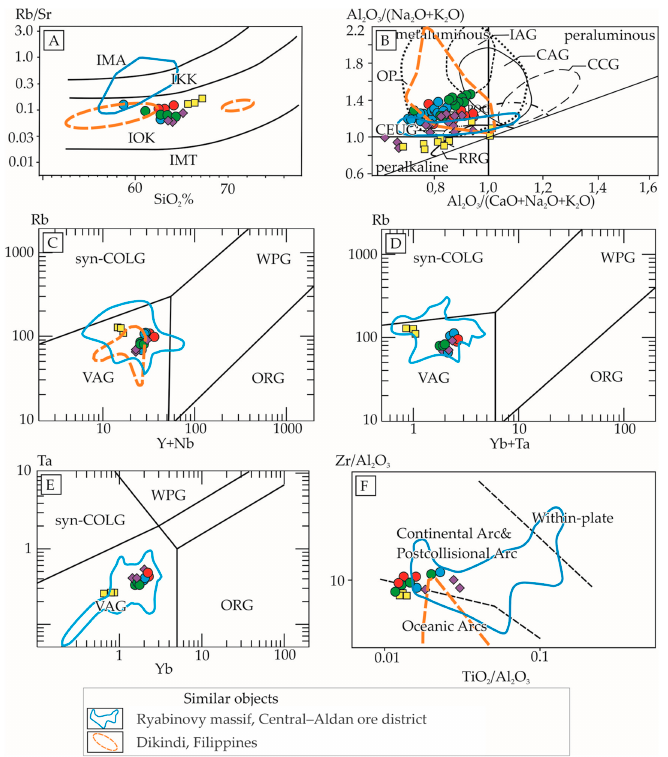
Figure 6. Discrimination diagrams for igneous rocks of the Medvedev, Taezhniy massifs and similar objects [10,24]. Blue line color is Ryabinovy massif, Central–Aldan ore district [14], Red line color is Dikindi, Filippines [1]. ( A ) Rb/Sr-SiO 2 diagram fields [43], igneous rocks: IMT—tholeiitic rock series, IKK—continental crust, IOK—oceanic crust, IMA—alkaline mantle; ( B ) Al 2 O 3 /(Na 2 O + K 2 O) − Al 2 O 3 /(CaO + Na 2 O + K 2 O) diagram fields [46]: IAG—island arc granitoids, CAG—granitoids of continental arcs, CCG—granitoids of continental collision settings, POG—postorogenic granitoids, RRG—rift-related granitoids, CEUG—granitoids of continental epiorogenic uplifts, OP—oceanic plagiogranites; ( C – E ) Rb − Y + Nb, Rb − Tb + Ta, Ta − Yb diagram fields [45]: ORG—granites of oceanic ridges, WPG—intraplate granites, VAG—granites of volcanic arcs, syn-COLG—collision granites; ( F ) Zr/Al 2 O 3 − TiO 2 /Al 2 O 3 diagram for various geodynamic settings according to [47]: WIP— intraplate rocks, CAP + PAP – marginal—continental and post-collision volcanic arcs, OAR—oceanic arcs. The other symbols are same as in Figure